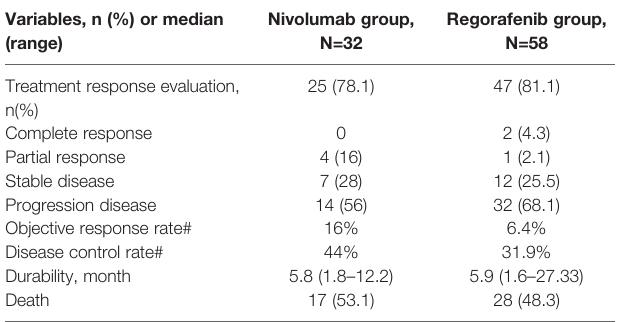
TABLE 2 | Tumor response in the study population by